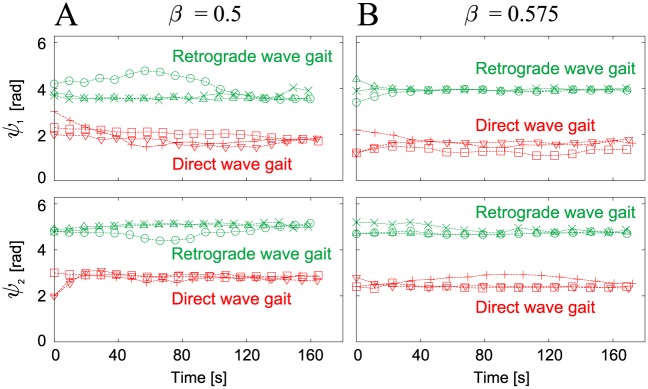
Relative phases (ψ1, ψ2) of the robot experiments plotted at foot contacts of Leg 2.Relative phases are plotted for six initial conditions with (A) β = 0.5 and (B) β = 0.575. The six different markers represent the results for the six initial conditions. Irrespective of the value of β, the robot established two different gaits that were dependent on the initial conditions.